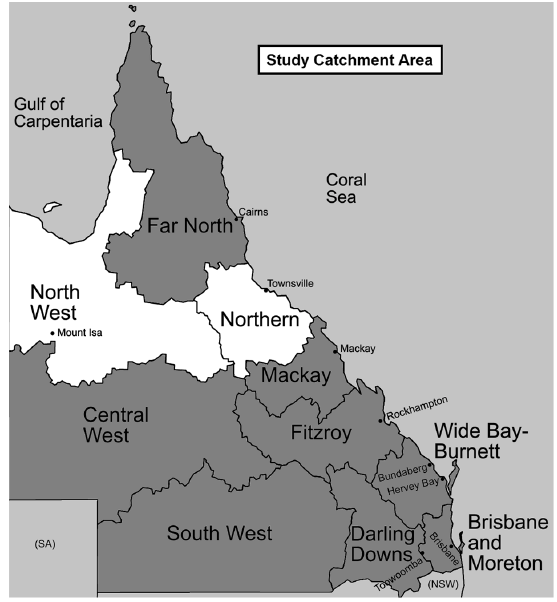
Figure 1. Fresh faecal specimens sampled for Strongyloides PCR were submitted from laboratories in the regions indicated. 90.7% of specimens received came from patients residing in these areas, and 95% of specimens positive by qPCR came from patients residing in these areas. Two positive specimens came from the Far North and Central West regions, and one specimen came from a small community (not shown) just over the western border of the North West